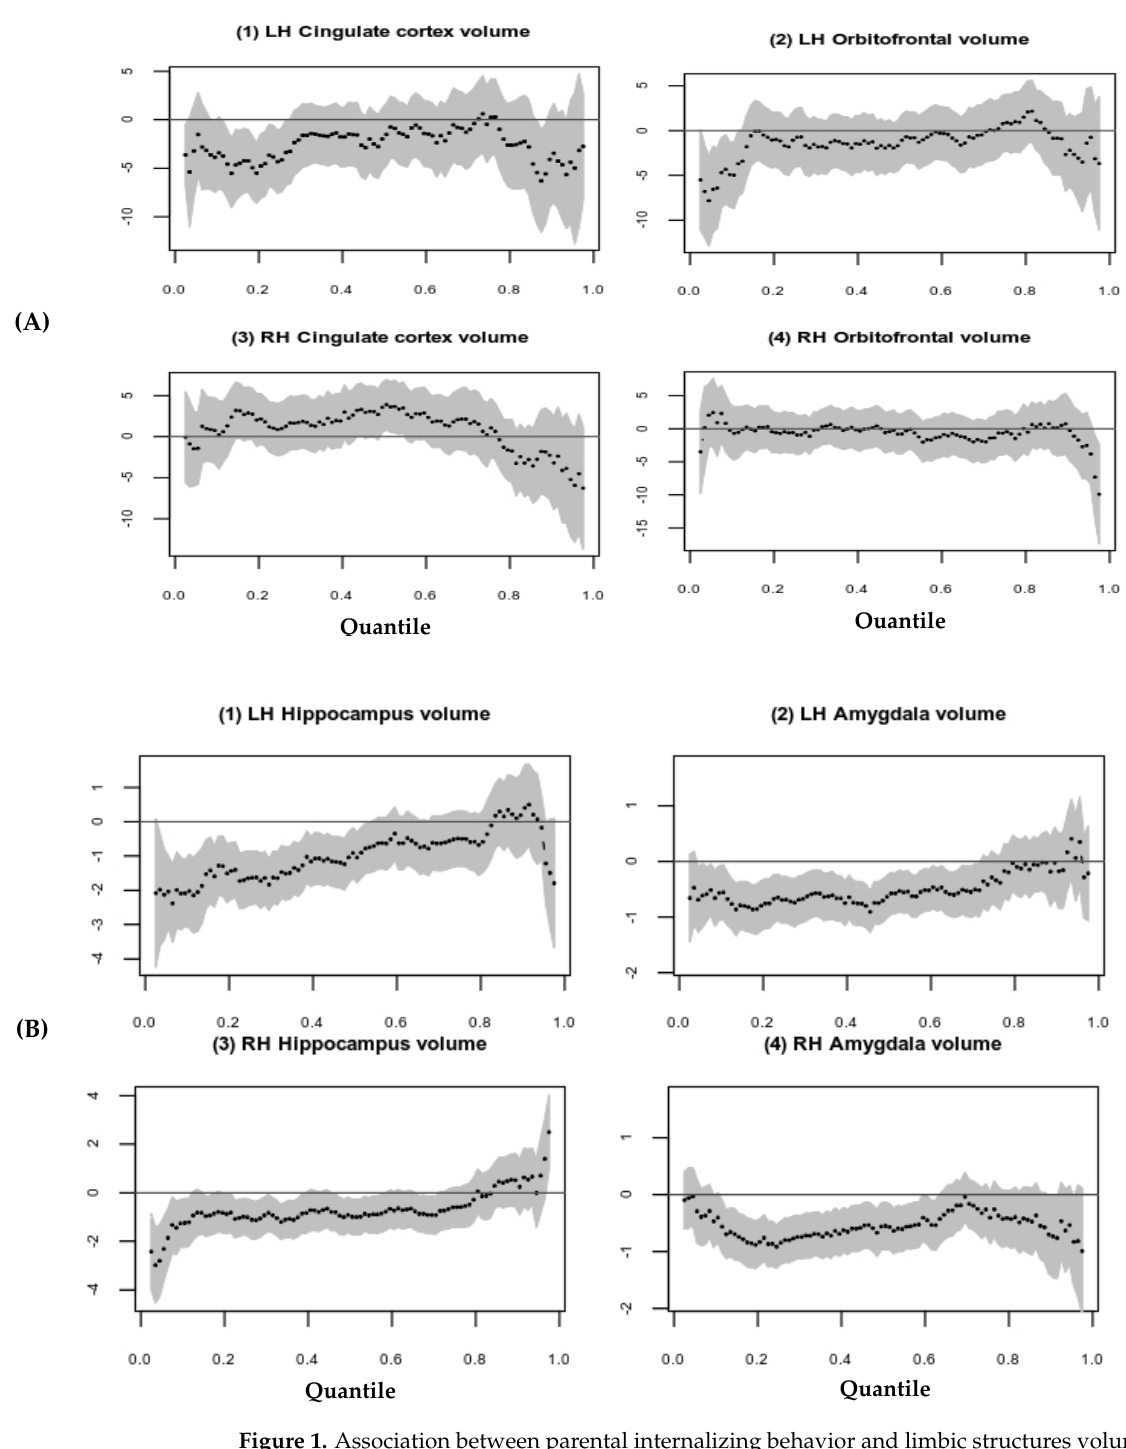
Figure 1. Association between parental internalizing behavior and limbic structures volume (mm 3 ) using Quantile regression plots. ( A ) Association between parental internalizing behavior (y-axis) and cortical limbic structures (x-axis); ( B ) Association between parental internalizing behavior (y-axis) and subcortical limbic structures (x-axis).